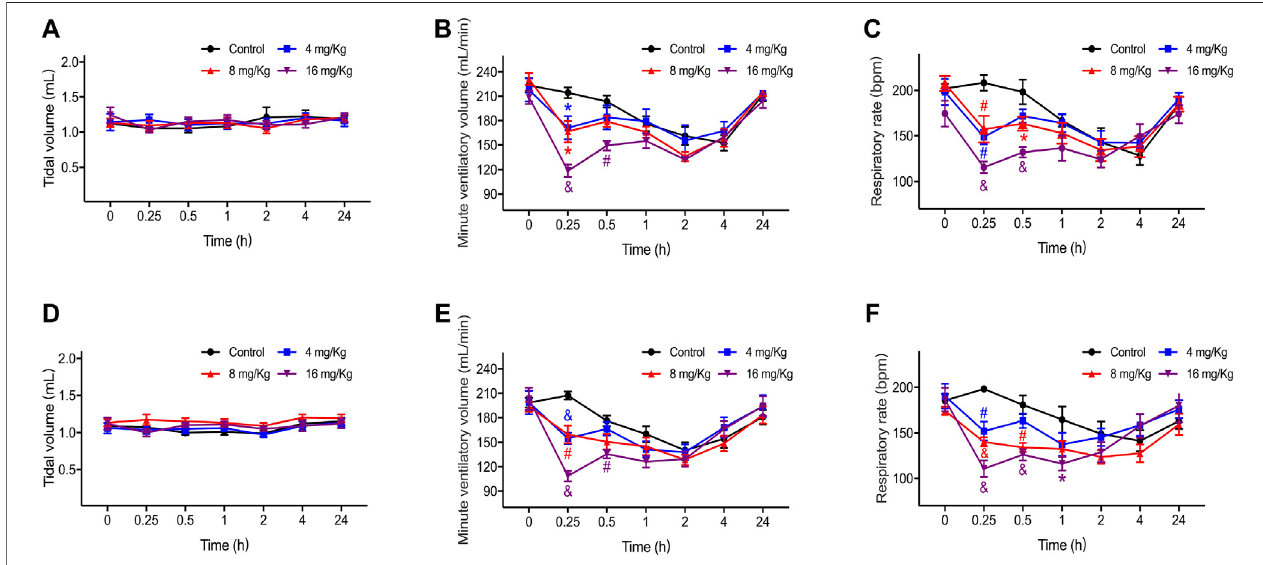
FIGURE 1 | The result of tidal volume, respiratory rate and minute ventilation in male (A – C) and female (D – F) rats. Data were depicted as the mean ± SEM. Compared with control group, * p < 0.05; # p ≤ 0.01; & p ≤ 0.001.